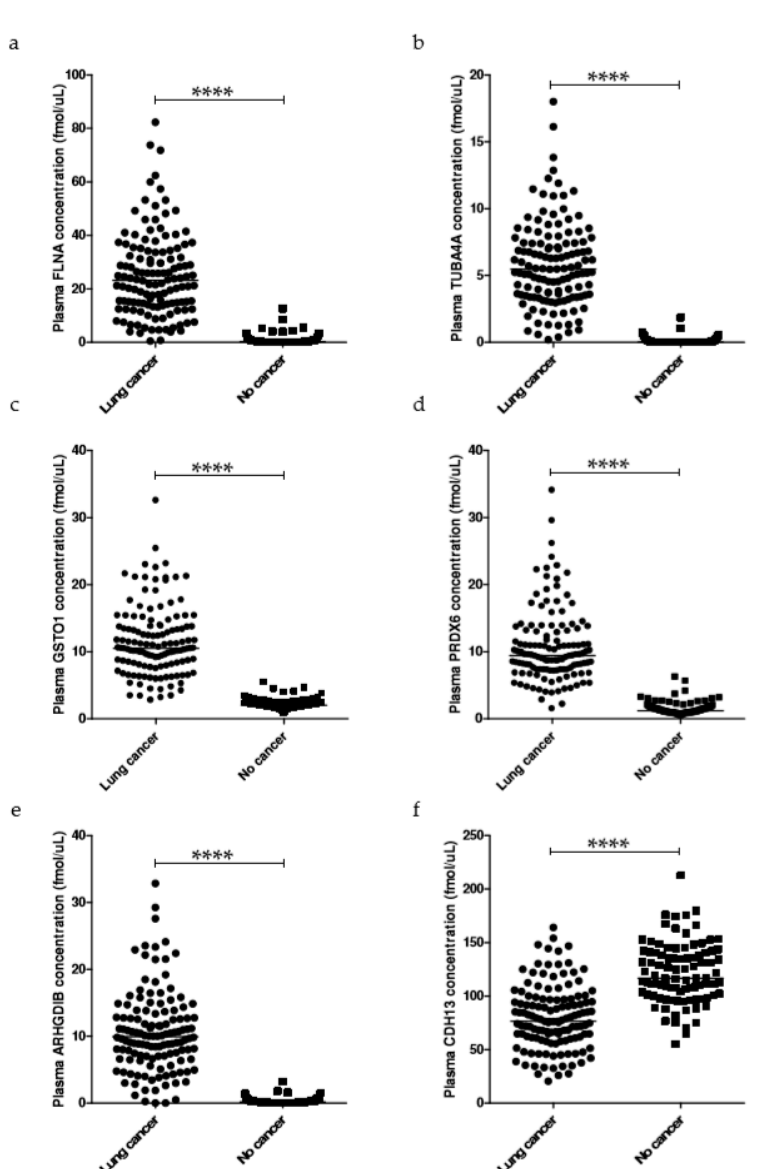
Figure 2. Plasma levels of the 6 protein biomarkers identified as a lung cancer diagnostic panel. Scatter plots of ( a ) filamin-A (FLNA), ( b ) tubulin alpha-4A chain (TUBA4A), ( c ) glutathione S-transferase omega-1 (GSTO1), ( d ) peroxiredoxin-6 (PRDX6), ( e ) rho GDP-dissociation inhibitor 2 (ARHGDIB) and ( f ) cadherin-13 (CDH13) concentrations obtained from lung cancer patients ( n = 128) and healthy volunteers ( n = 93) using the LC-PRM assay targeting proteotypic peptides. Data points and their median are shown. **** Adjusted p < 0.0001 using the non-parametric Kruskal–Wallis test.